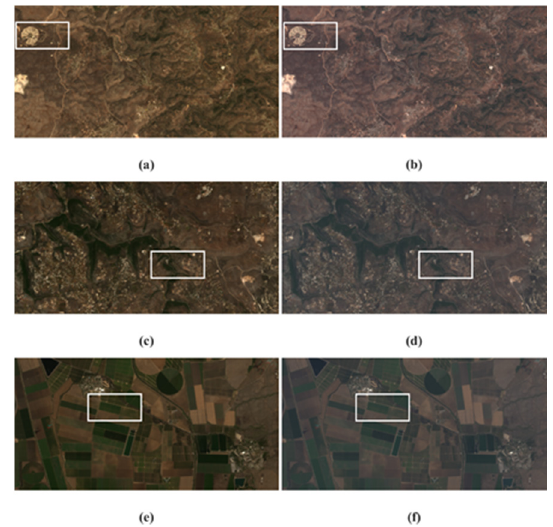
Figure 6. RGB composite of datasets in Group-1 used for the experimental evaluation. ( a ) and ( b ) Landsat images with low SR (LSR) of 30 m and corresponding sentinel image with HSR of 10 m, respectively. ( c ) and ( d ), Venus image with LSR of 10 m and corresponding Venus image with HSR of 5 m, respectively. ( e ) and ( f ), Venus image, over homogeneous regions, with LSR of 10 m and corresponding Venus image with HSR of 5 m, respectively. White rectangles denote areas used for visual analysis.